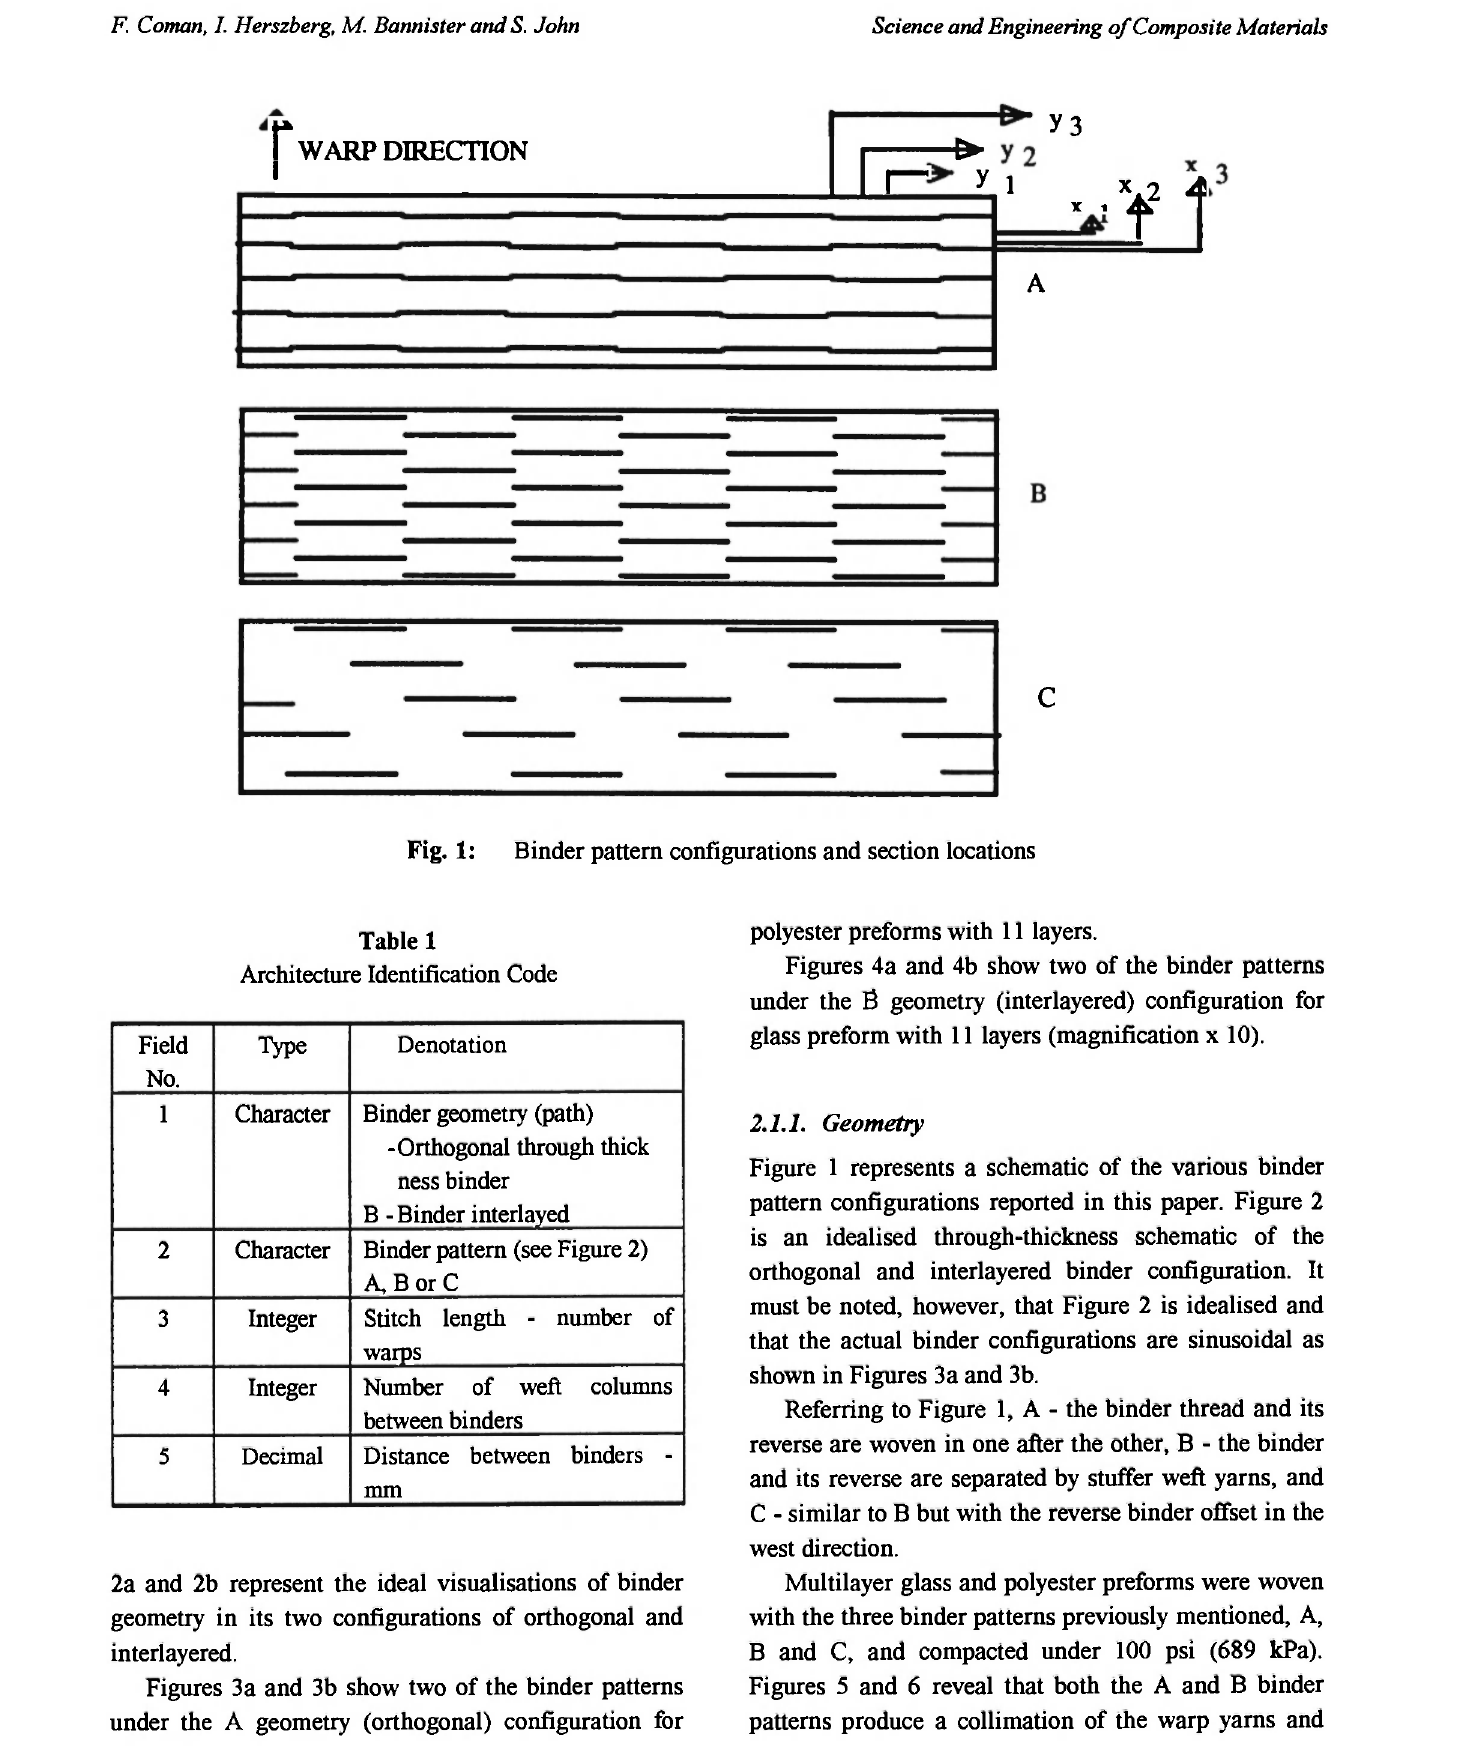
Binder pattern configurations and section